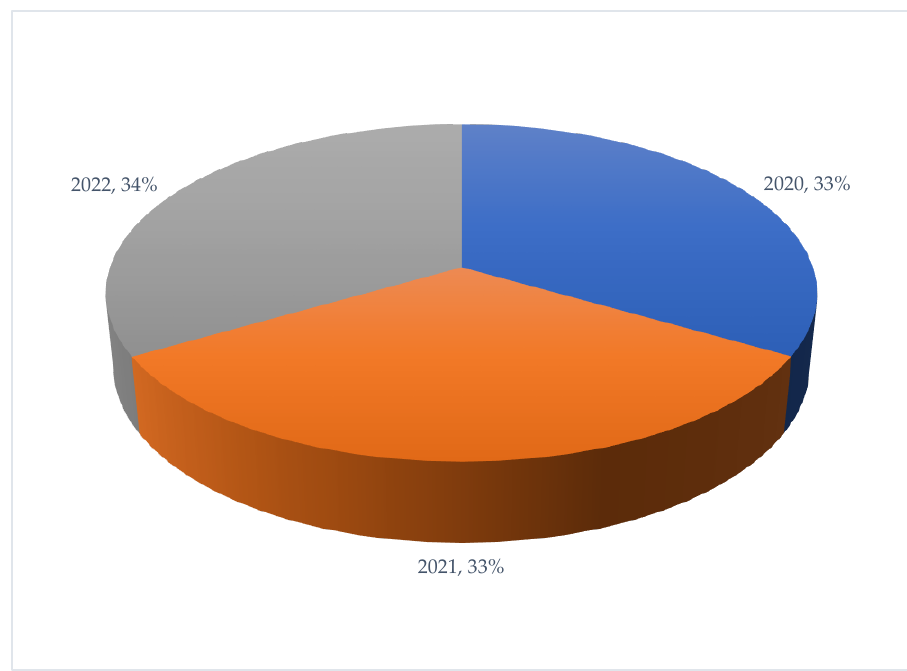
Figure 1. Annual distribution of published papers.